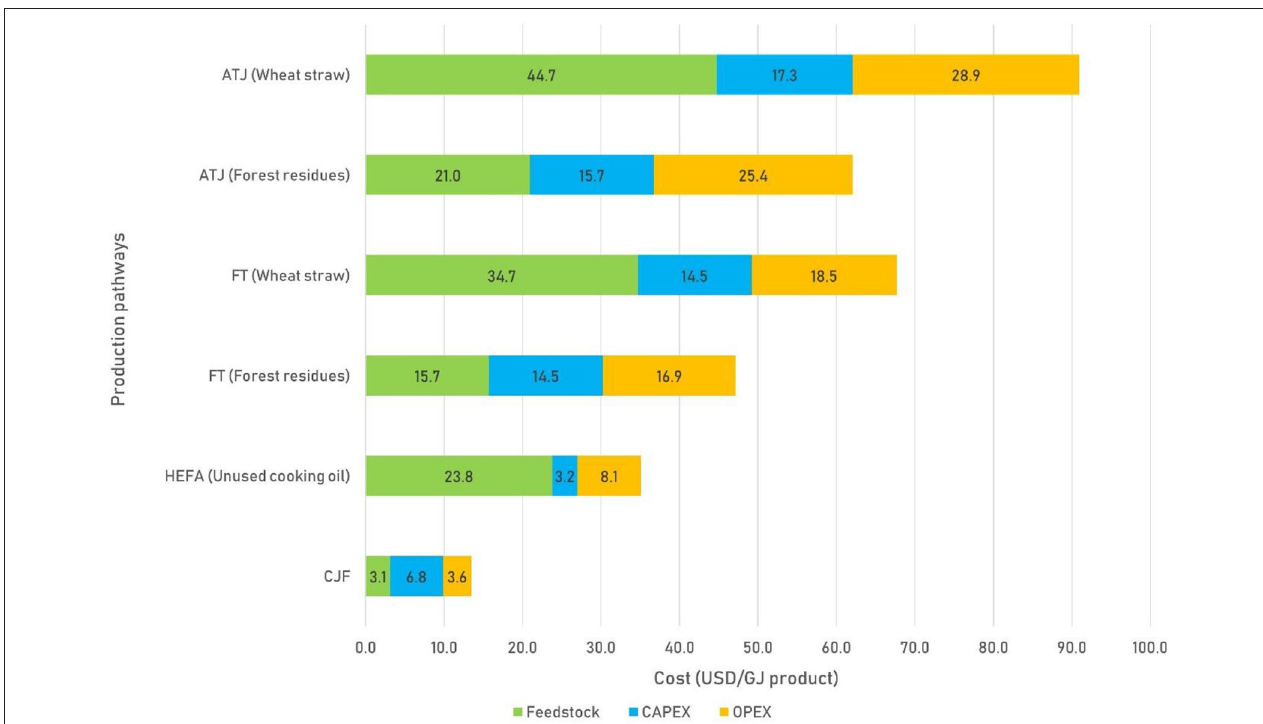
FIGURE 6 | Breakdown of cost (adjusted to 2019 levels) of producing bio-aviation fuel by HEFA, FT and ATJ (Plotted using production cost of the production pathways from de Jong et al., 2015). Production cost of CJF by crude oil refinery, which was calculated and adjusted to 2019 levels from data of Sannan et al. (2017) and US EIA (2020), is also plotted for comparison.